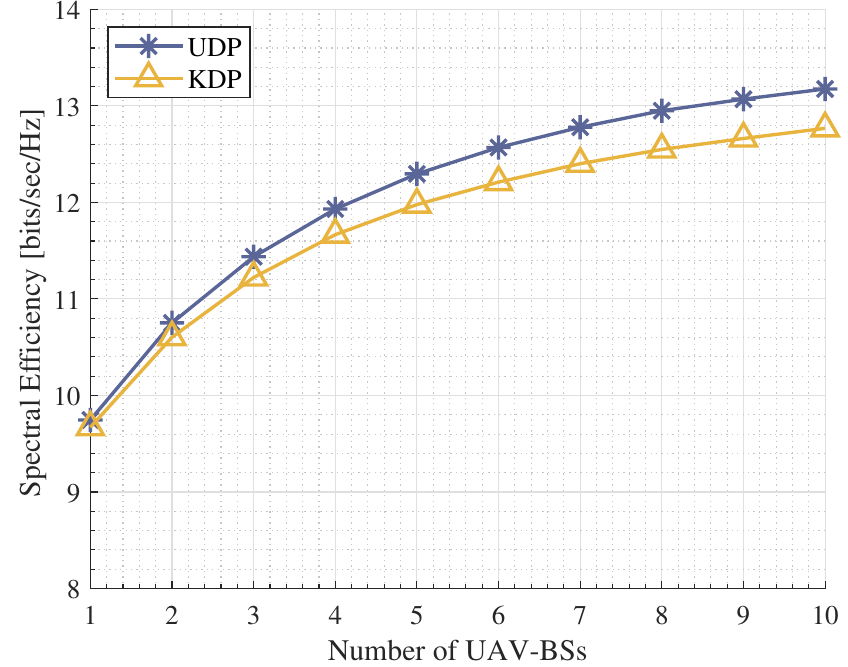
Figure 8. Average UE spectral efficiency for different number of